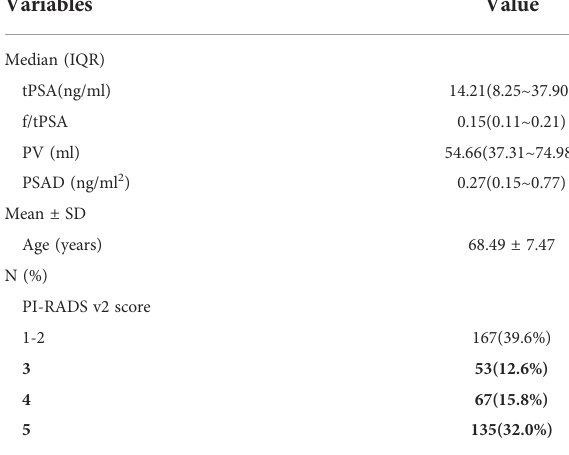
TABLE 1 Patients ’